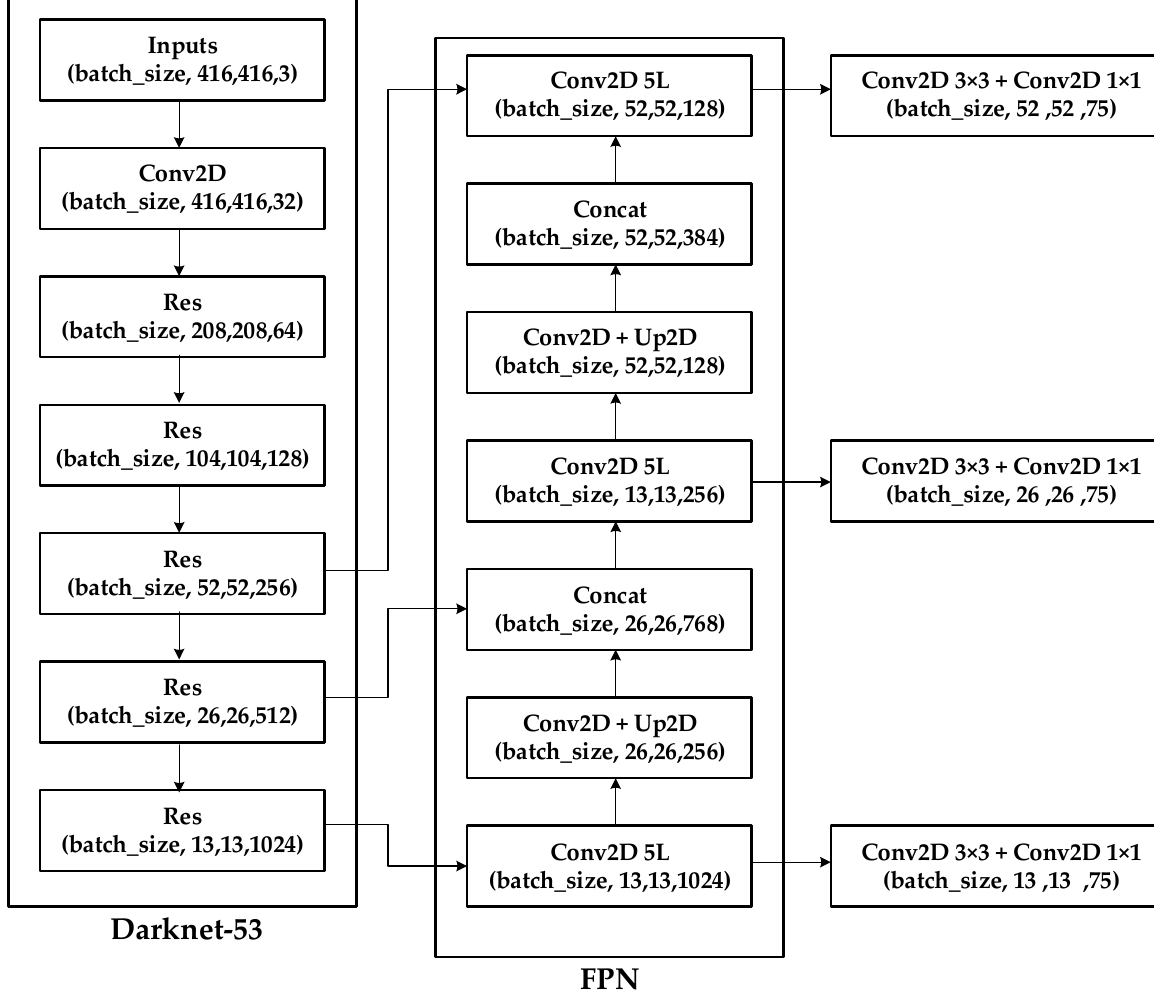
Figure 12. Schematic diagram showing the architecture of YOLO v3.